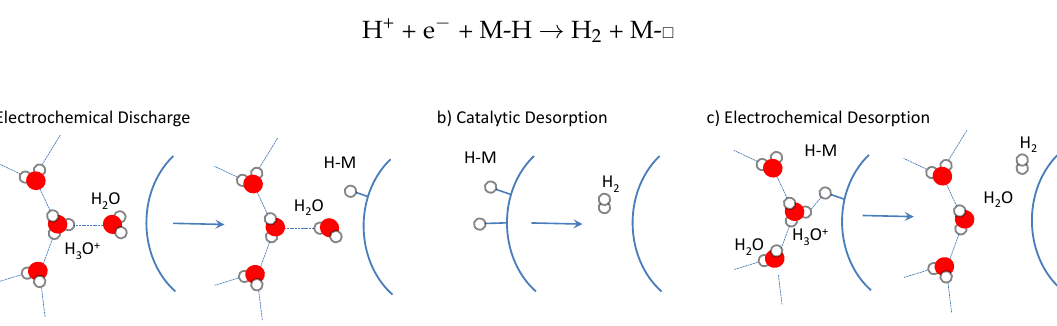
Figure 4. Electrochemical hydrogen evolution processes: ( a ) electrochemical discharge, or Volmer step; ( b ) catalytic desorption, or Tafel path; ( c ) electrochemical desorption, or Heyrovsky path. Adapted with permission from [38]. Copyright 1979 American Chemical Society.